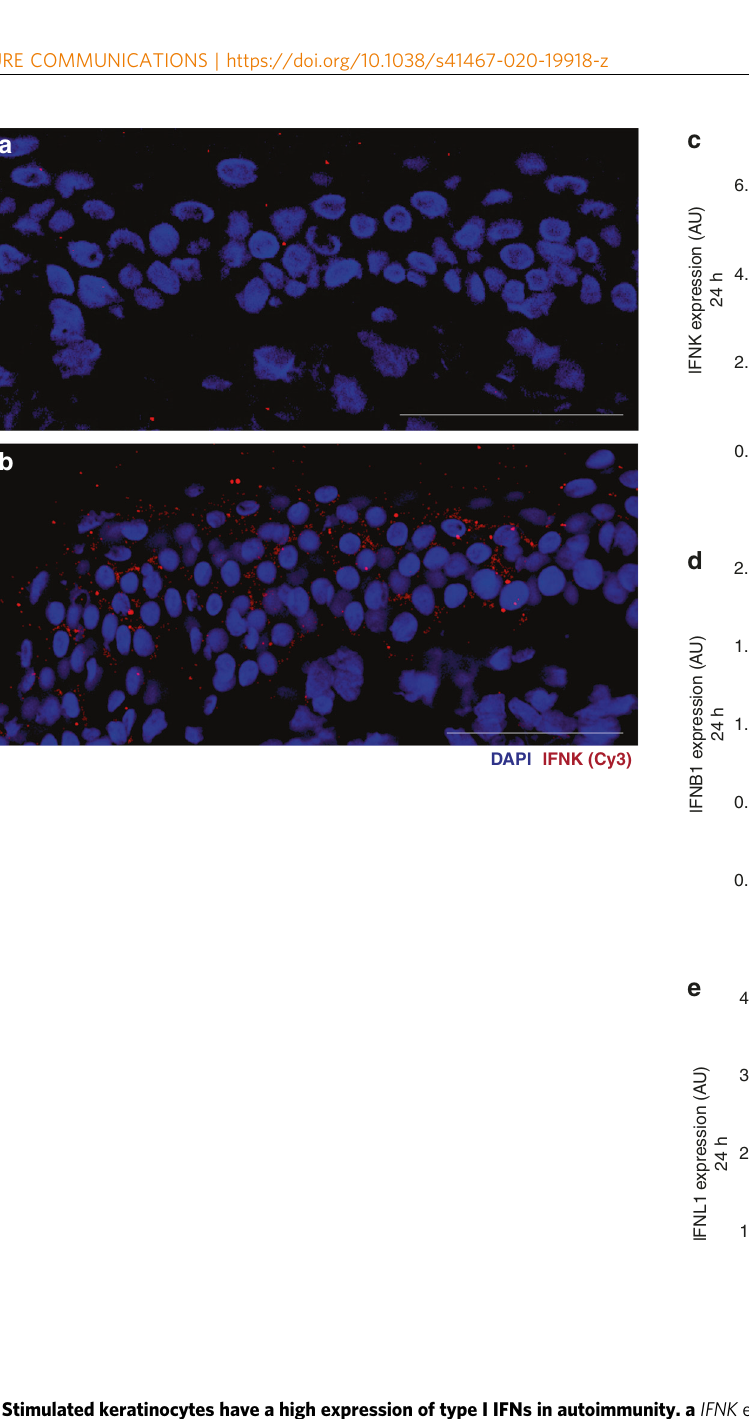
Fig. 8 Stimulated keratinocytes have a high expression of type I IFNs in autoimmunity. a IFNK expression in the epidermis of SLE patient with the inactive disease before UV provocation. b IFNK expression in the epidermis of the same SLE patient after UV provocation. c – e Human keratinocytes were isolated from fresh skin biopsies and were then cultured in the absence or presence of Poly I:C (1 μ g/mL) or Poly dA:dT (100ng/mL). The expression level of IFNK ( c ), IFNB1 ( d ), IFNL1 ( e ) in keratinocytes from healthy controls (HC), At-Risk individuals (At-Risk), SLE patients (SLE), and patients with cutaneous discoid lupus erythematosus (CDLE) after in vitro culture for 24h. Data are represented as mean ± SEM. Scale bars: 100 µ m. * P < 0.05. Two-way ANOVA ( c – e